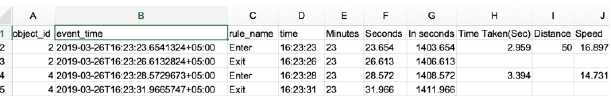
Figure 6. Logged .CSV file of events generated on